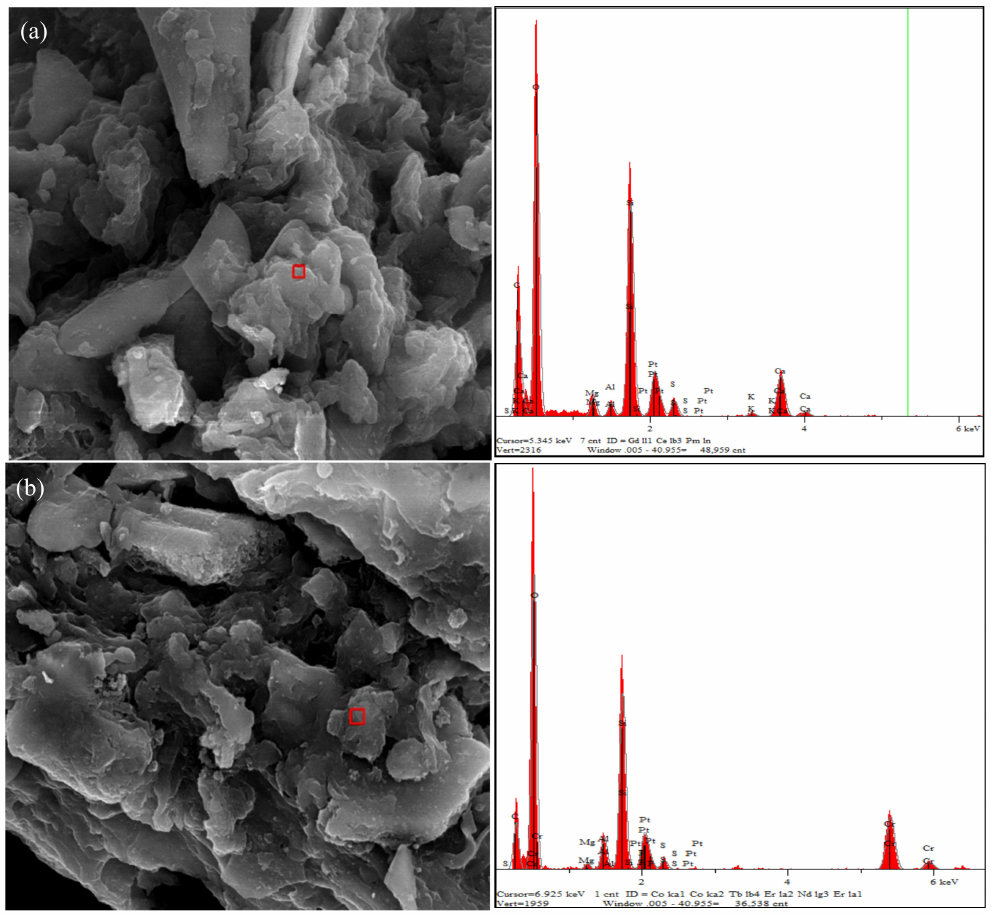
Figure 8. Energy dispersive X-ray (EDX) analysis of MSB300 before ( a ) and after reaction ( b ).